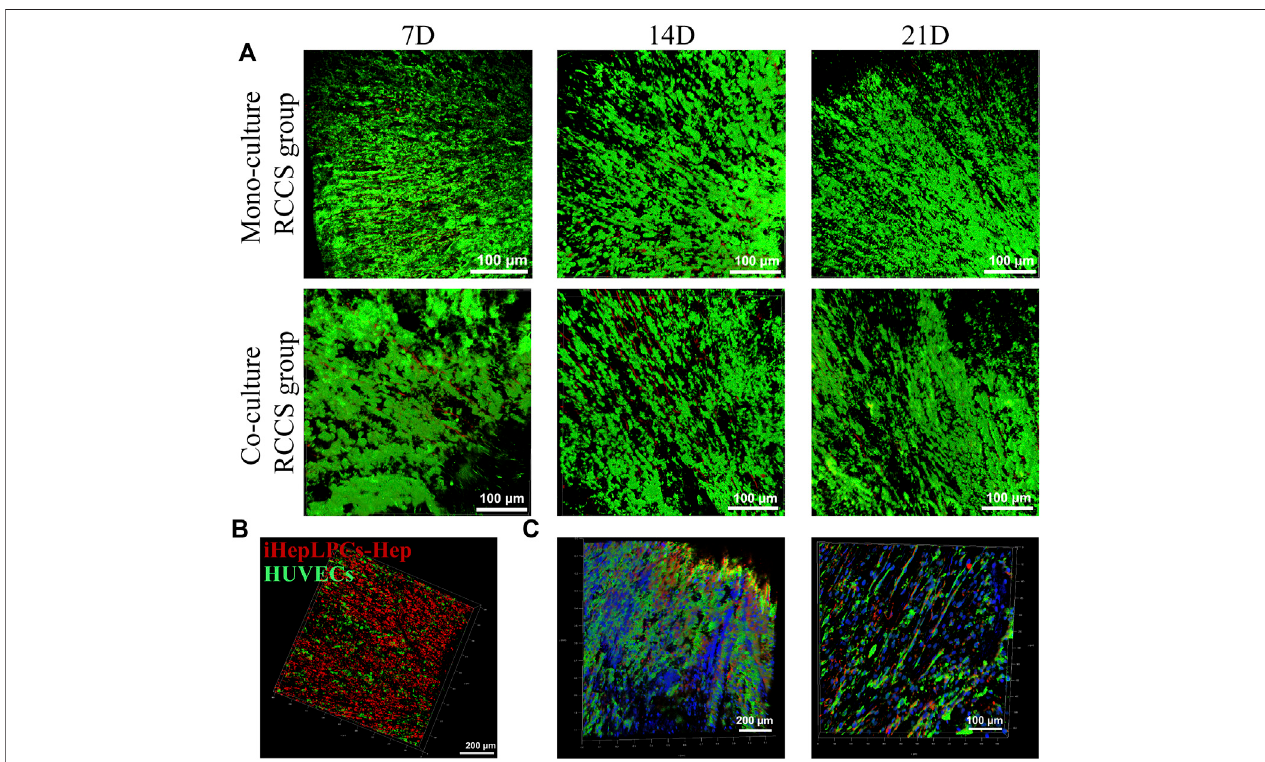
FIGURE5| Growthpro fi lesofiHepLPCsoncompositeSFCscaffolds.Theviabilitystainingofbothmonoculturesandco-culturesisshown.Alignedgrowthpattern of the monocultured or co-cultured cells over time were observed using CLSM (A ). Radially aligned hepatocyte and endothelial cell interphase arrangement of 3D co- cultures was revealed using cell-tracker dye staining (B) (red, iHepLPC-Heps; green, HUVECs) and IF staining (C) (green, ALB-FITC-conjugated secondary antibody- labeled iHepLPC-Heps; red, CD31-Alexa Fluor647-labeled HUVECs; blue, DAPI) under CLSM.